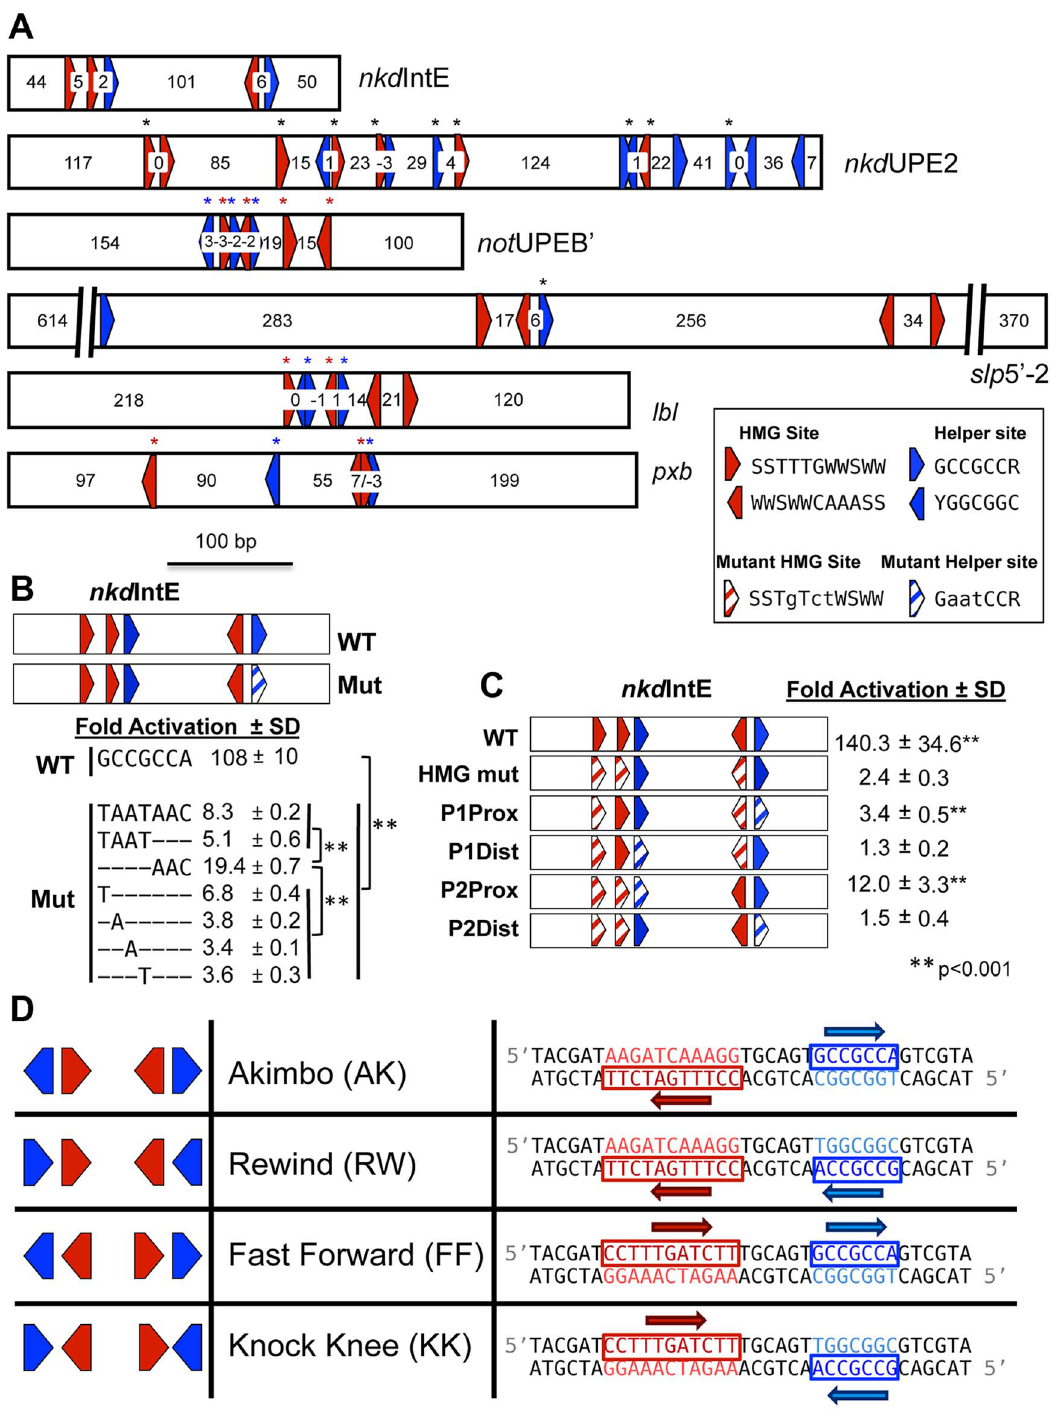
Figure 1. HMG and Helper site configurations in W-CRMs. (A) Previously characterized W-CRMs [44,57] with location of predicted HMG (red arrows) and Helper (blue arrows) indicated (see Figure S3 for PWMs of these motifs). Cutoffs for HMG and Helper sites were 5.35 and 6.5, respectively. Direction of arrow indicates orientation of motif (see inset for consensus sequences in both orientations). Number of nucleotides between each motif is indicated. Black asterisks indicate sites that contributed to W-CRM activation by Wnt signaling in cell culture when mutated individually [44,57]. Red and blue asterisks denote function when all indicated HMG or Helper sites were mutated simultaneously. (B) Systematic mutagenesis of second Helper site in the nkd IntE W-CRM reporter indicates all seven positions contribute to W-CRM activation. Letters indicate mutated nucleotides, with dashes denoting the wild-type sequence. Reporter constructs were transfected into Drosophila Kc cells with or without a plasmid expressing Arm*. Fold activation represents the ratio of Arm*/control, SD equals standard deviation of three biological replicates. (C) HMG and Helper sites work in closely spaced pairs. The nkd IntE reporter contains three functional HMG and two functional Helper sites [44], which were mutated (striped arrows) in different combinations, and tested for Arm* activation in Kc cells. Values represent the mean of three biological replicates 6 SD. A Student’s T-test was employed to determine significance for data in panels B and C. (D) Nomenclature and symbology for the four possible HMG-Helper site pair